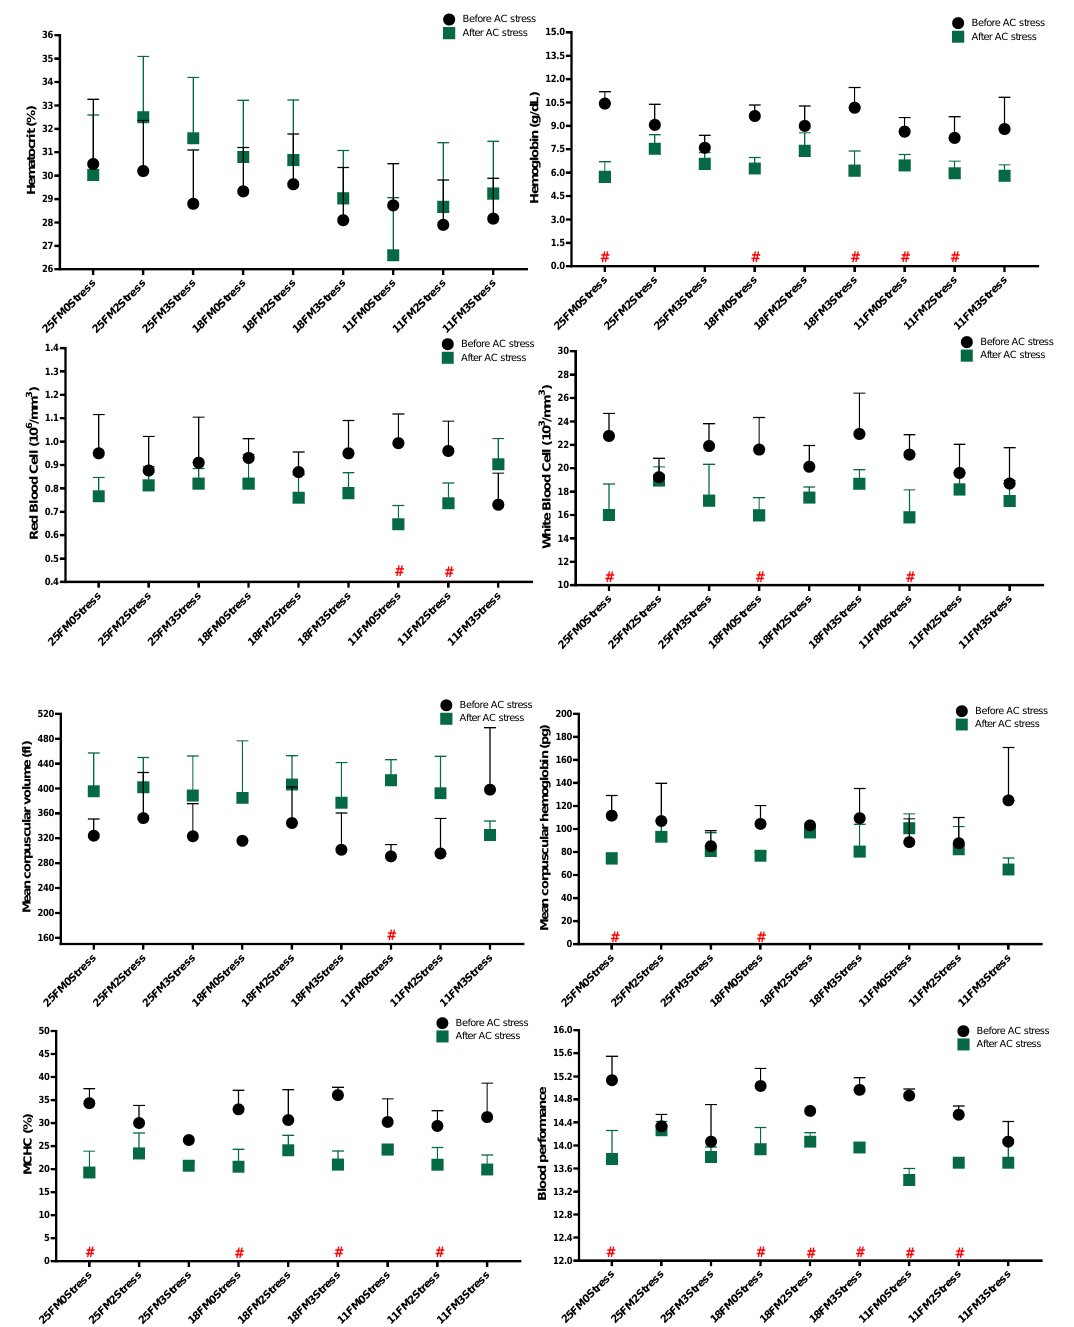
Figure 1. Haematological parameters of oscar fed experimental diets containing different levels of FM and exposed to secluded early mild stress for ten weeks plus data related to after acute confinement stress (AC stress). Values are represented by means and SDM of triplicate samples. Hash (#) with red colour indicates the significant difference in each treatment before and after AC stress according to the independent sample t -test ( p < 0.05).